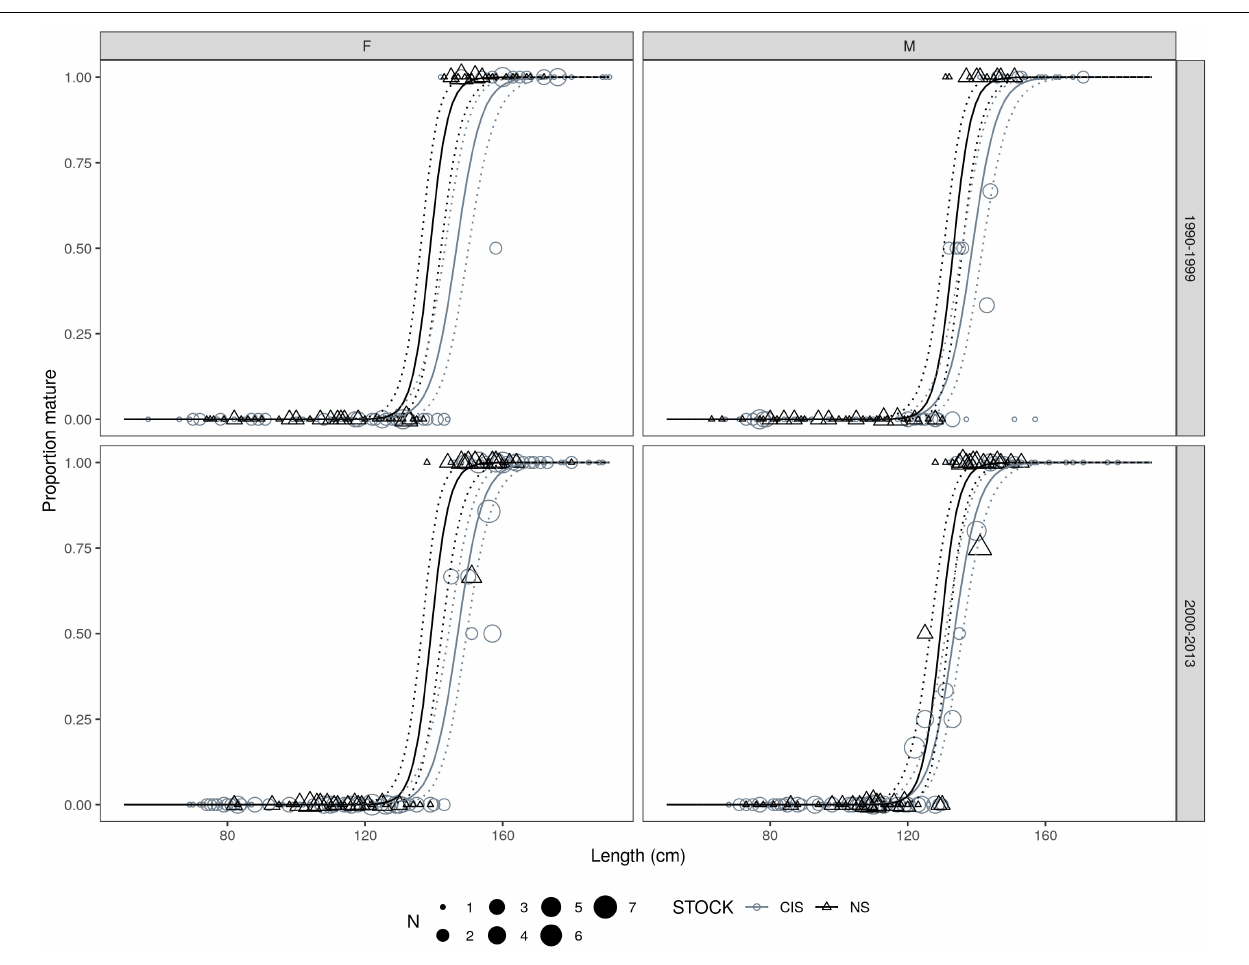
FIGURE 9 | Best fitting length (cm) at maturity model fits by sex, time period, and management unit. Points are scaled proportional to the number of observations for a given proportion. Solid and dashed curves represent the mean and 95% confidence intervals on the estimated proportion mature,